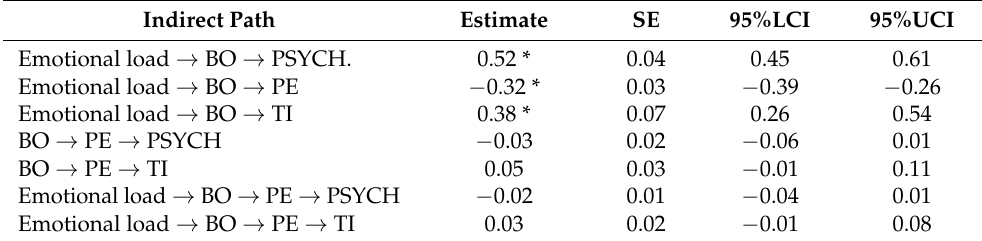
Table 4. Indirect effects with 95% confidence